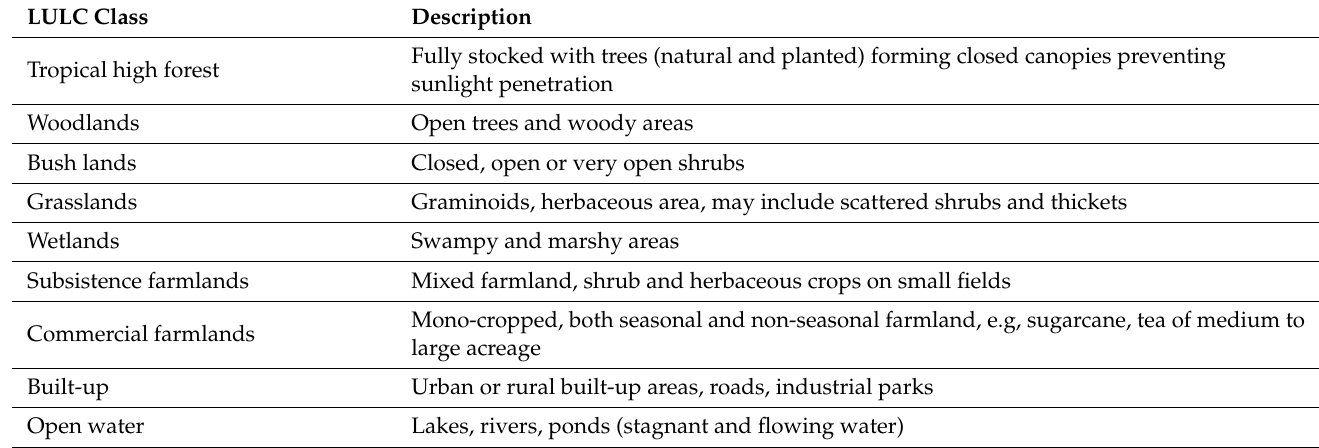
Table A2. Description of land use/land cover classes in Budongo–Bugoma landscape.